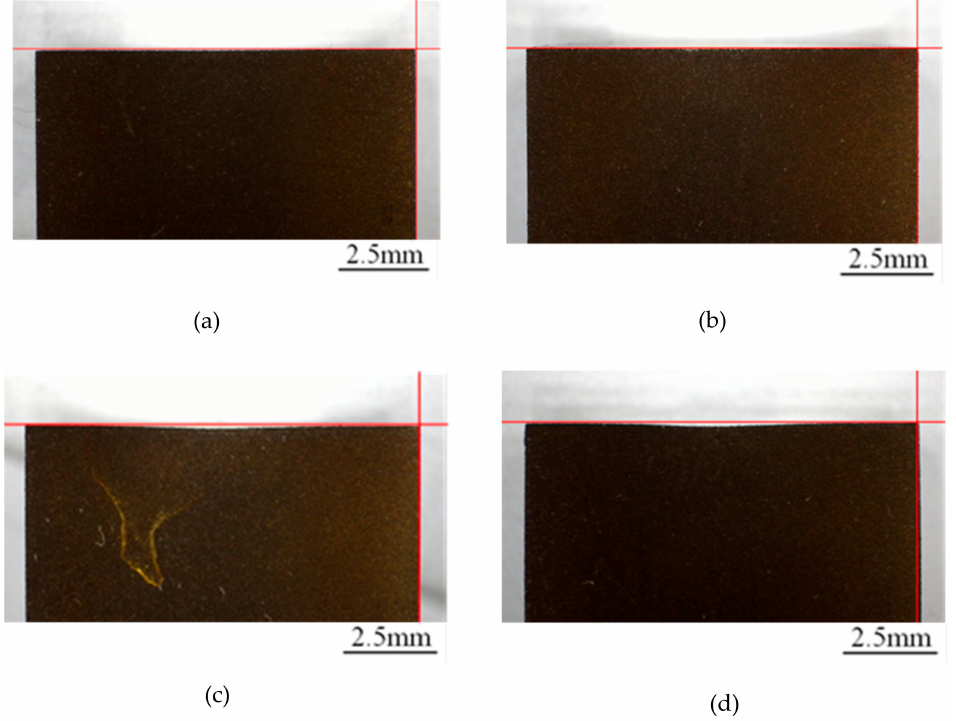
Figure 10. Cross-section image of the specimen after 14,000 forging cycles: ( a ) 150—WL; ( b ) 150—WOL; ( c ) 180—WL; and, ( d ) 180—WOL. (150 / 180—Forging load (kN), WL—With Lubrication, WOL—Without